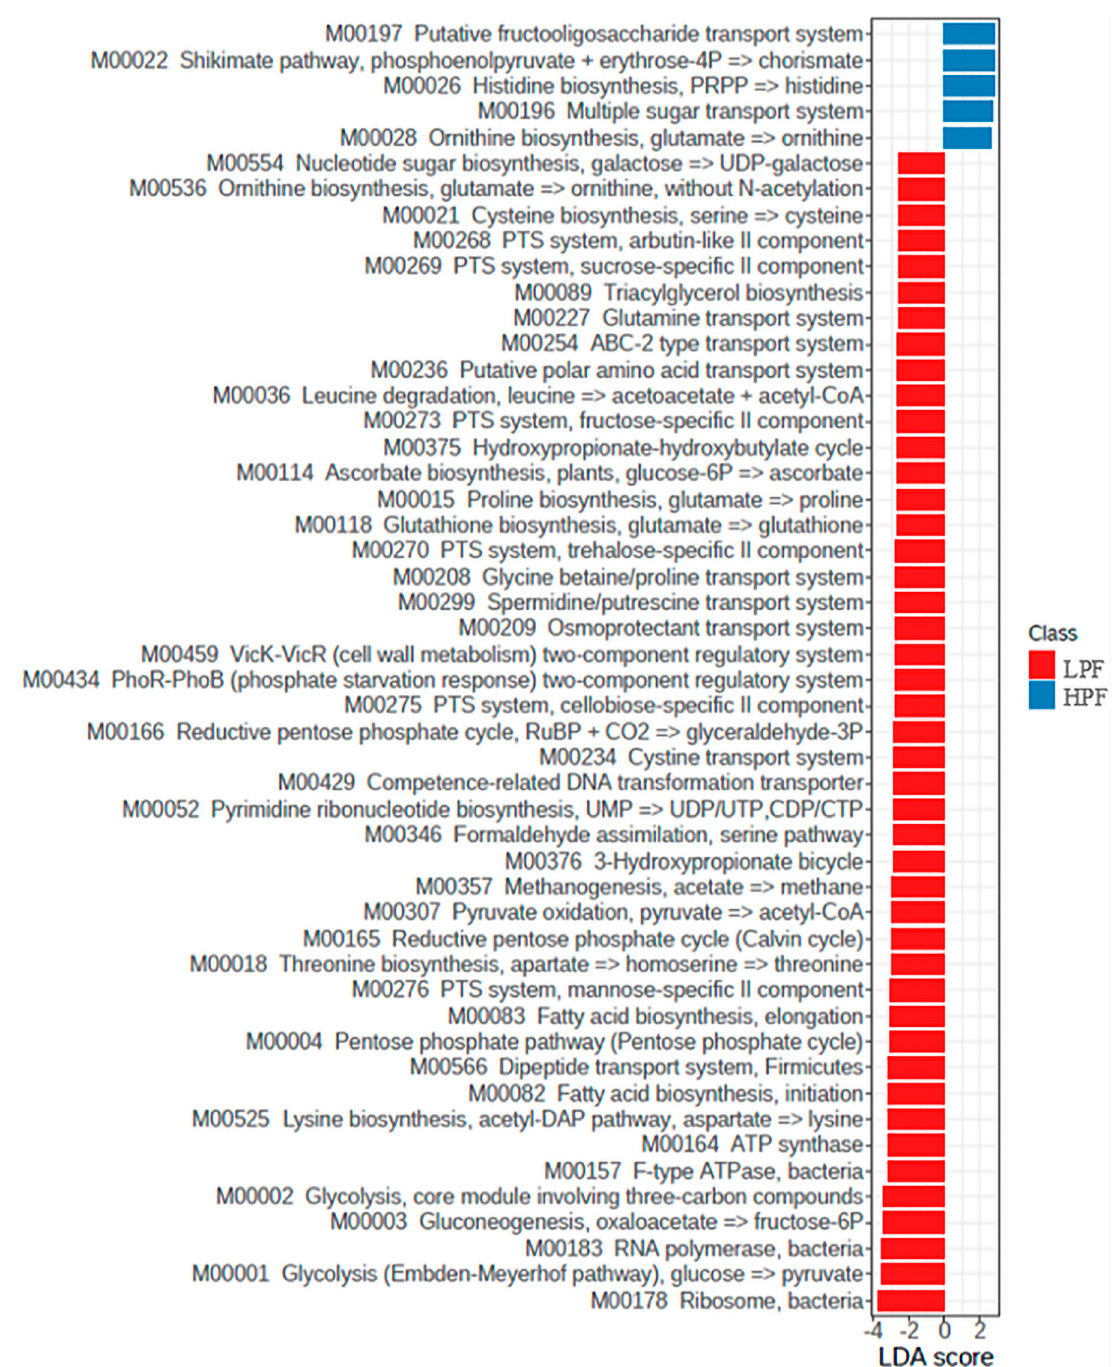
Figure 5. LDA score of KEGG Modules that statistically differ ( p < 0.05) between the lower protein and fiber diet (LPF, day 21) and the higher protein and fiber diet (HPF, day 49).